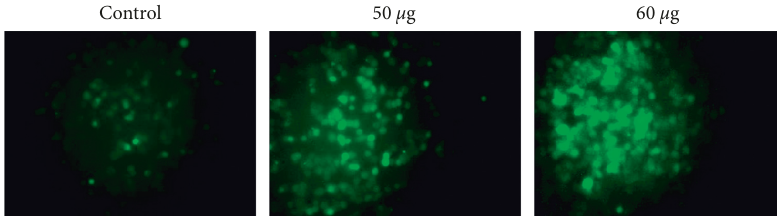
Figure 8: DCFH-DA staining method for examination of ZnO-TiO